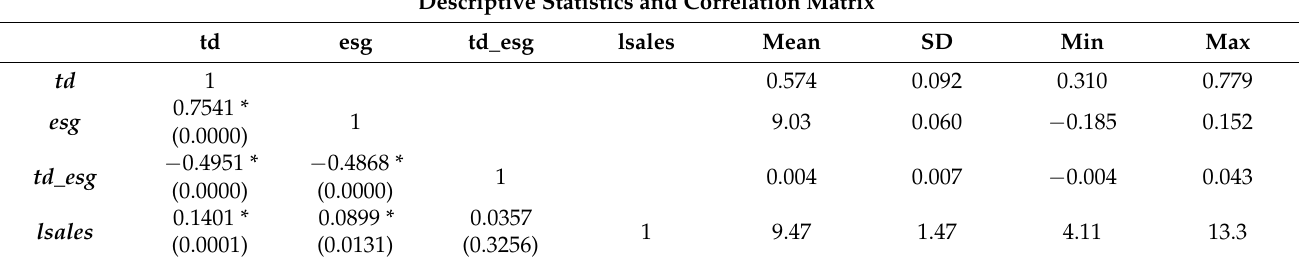
Table 2. Descriptive Statistics and Correlation.